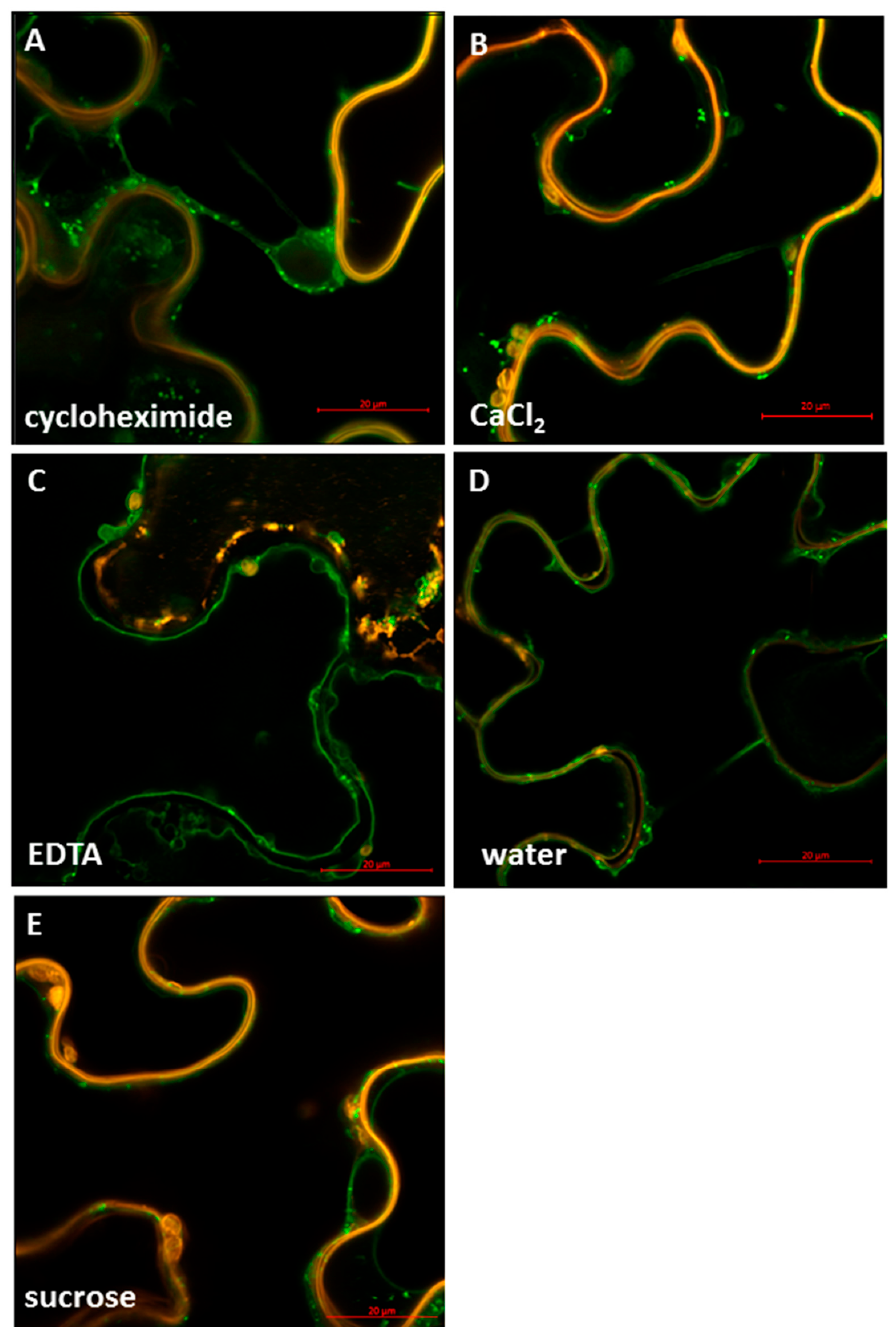
Figure 7. E ff ect of di ff erent e ff ectors on the sub-cellular localization of StSUT4. The infiltrated leaves were incubated overnight at room temperature in di ff erent substrate solutions: 10 µ M Cycloheximide ( A ), 50 mM CaCl 2 ( B ), 50 mM EDTA ( C ), and 500 mM sucrose ( E ) using water as a control ( D ). The treated leaf discs were then transferred to water and observed under the Confocal Microscope ( A ). Movement of StSUT4-YFP towards perinuclear membranes and increase in the number of vesicles with no change of the PM marker (CBL1-OFP) after overnight incubation in 10 µ M Cycloheximide. ( B ). Formation of vesicles in the presence of divalent calcium ions. ( C ). Overnight incubation in 50 mM EDTA a ff ects the PM marker CBL1-OFP but not the localization of StSUT4. ( D ). No change in the localization of StSUT4 in the water control. ( E ). Movement of StSUT4-YFP in smaller vesicles in the presence of 500 mM